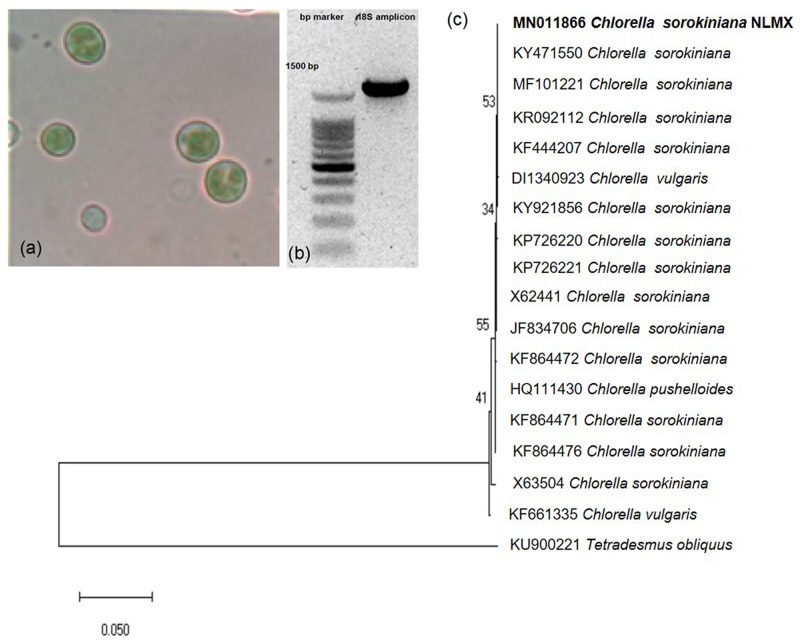
Microalgae phenotypic and molecular characterization. (a) Microscopic characteristics of Chlorella spp. (b) Partial amplification of Chlorella spp. 18S ribosomal RNA gene, (c) Phylogenetic analysis of 18S ribosomal RNA amplicon which clustered with previously reported Chlorella sorokiniana sequences. The evolutionary history was inferred by using the Maximum Likelihood method and Tamura-Nei model. The tree is drawn to scale, with branch lengths measured in the number of substitutions per site. This analysis involved 18 nucleotide sequences. There were 1,596 positions in the final dataset. Evolutionary analyses were conducted in MEGA X (Kumar et al., 2018).